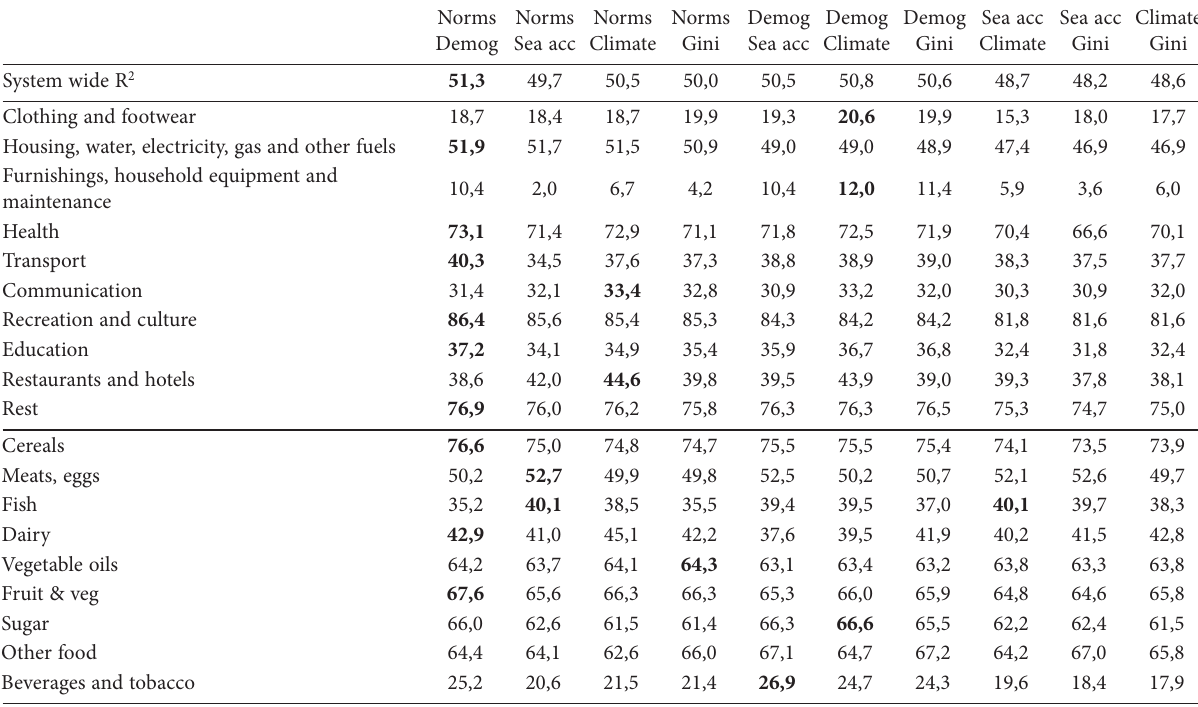
Table 7. Fit of different model variants by commodity group, two